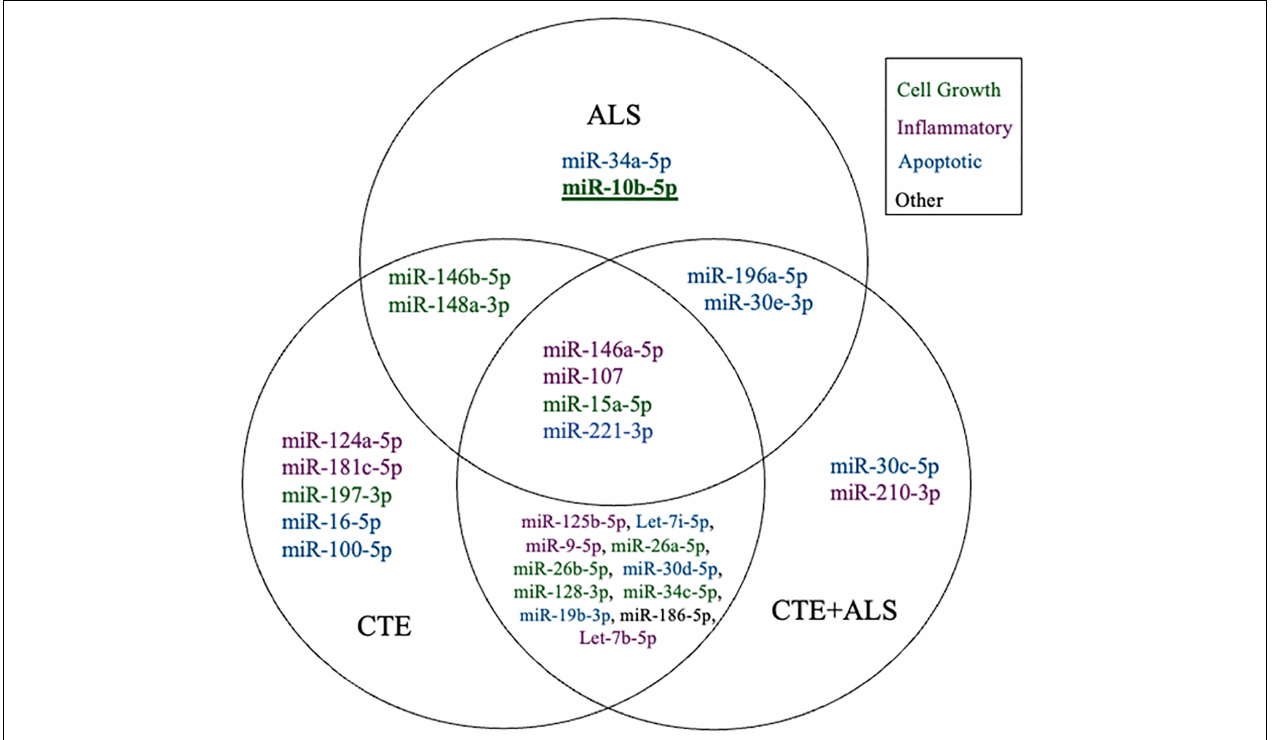
FIGURE 1 | Venn Diagram showing distinct and overlapping significantly altered miRNA within CTE, ALS, and CTE + ALS compared to controls. Bold and underline indicates a p-value at or below the Bonferroni number of 0.0013. Purple indicates miRNAs involved in inflammatory pathways; green indicates cell growth; blue indicates apoptotic; and black indicates miRNA that did not fit in any group.